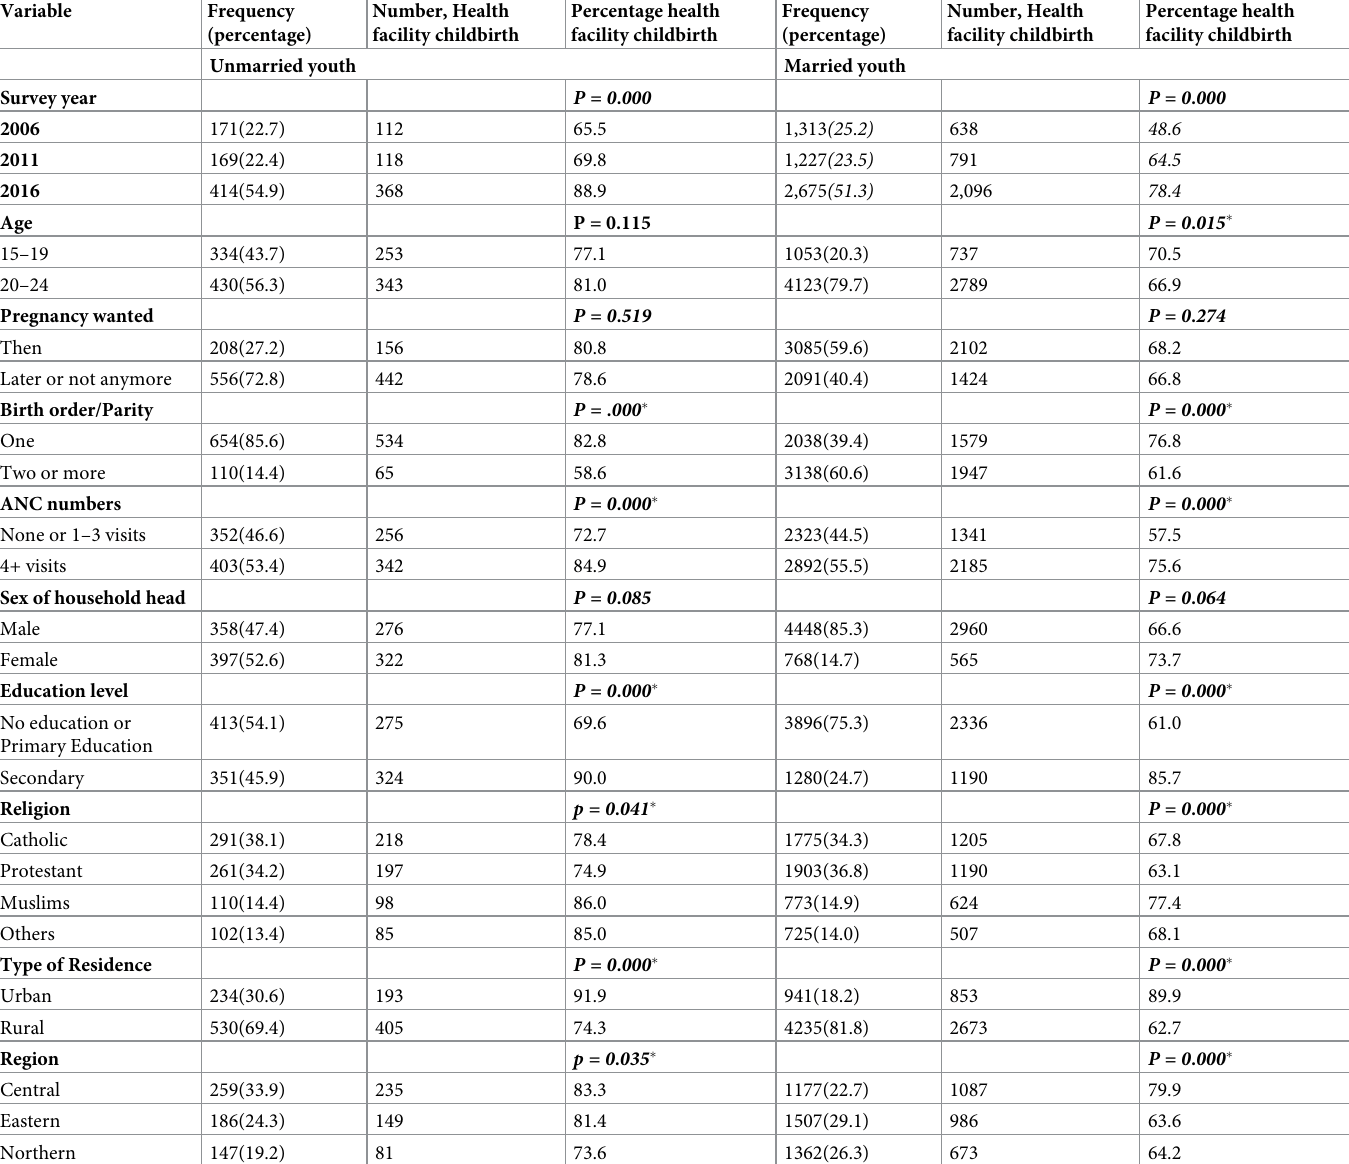
Table 2. Distribution of unmarried and married youth by background